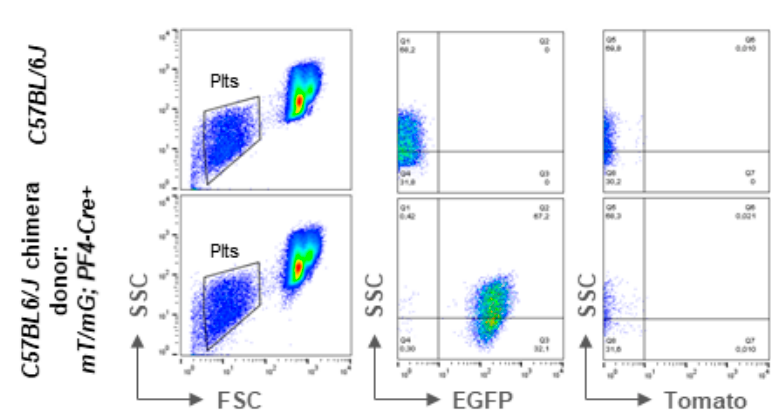
Figure 5. Transfer of bone marrow from mT/mG; PF4 ‐ Cre positive mice to C57BL/6 mice leads to the appearance of mG ‐ positive platelets in the circulation of chimeric mice. C57BL/6 mice were exposed to sublethal irradiation and received bone marrow cells of mT/mG;PF4 ‐ Cre positive mice. Platelet count ( A ), number of red blood cells ( B ) and leukocytes ( C ), hemoglobin concentration ( D ) and platelet size ( E , mean platelet volume) were determined in heparinized whole blood by a hematology analyzer (Sysmex, Norderstedt, Germany). No major differences between bone marrow chimeric mice and C57BL/6 controls could be detected, n = 5. ( F ) Platelets from bone marrow chimeric mice were analyzed regarding their mT and mG fluorescence in the SSC and FSC specific profile. Only platelets with mG fluorescence could be detected, n = 5. Statistical analysis was performed by two ‐ tailed Student ′ s t ‐ test . Bar graphs depict mean values ± SEM. Plts = plate ‐ lets.